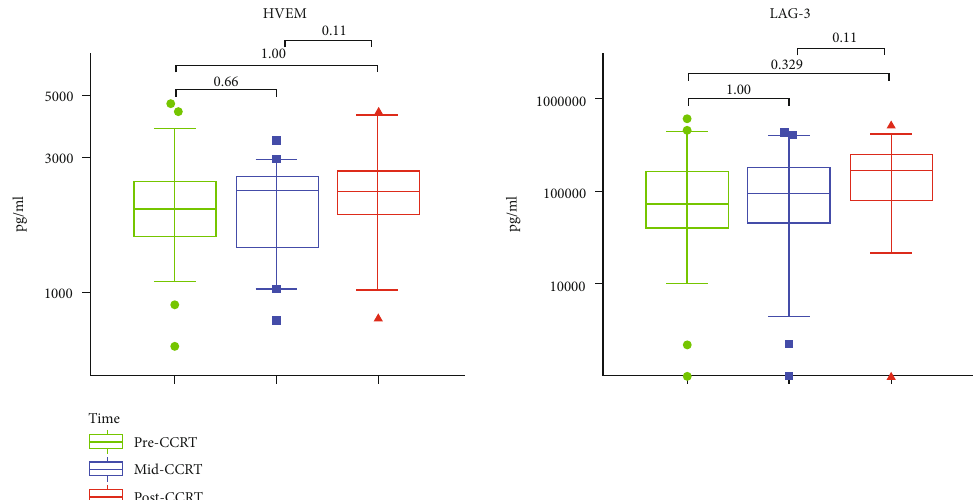
Figure 4: No changes in the levels of sICPs during the CCRT. The serum levels of HVEM and LAG-3 were compared among pre-CCRT (green), mid-CCRT (blue), and post-CCRT (red). P values were calculated using the Friedman test with Bonferroni ’ s